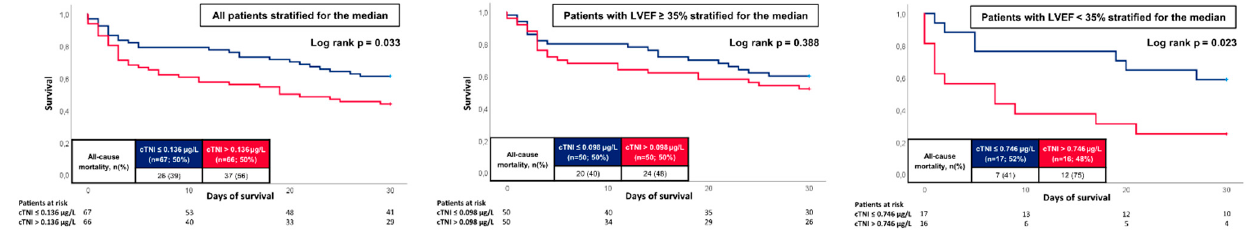
Figure 4. Kaplan–Meier curves for cTNI according to all-cause mortality at 30 days within the entire study cohort ( left ), in patients with LVEF ≥ 35% ( middle ) and LVEF < 35% ( right ).